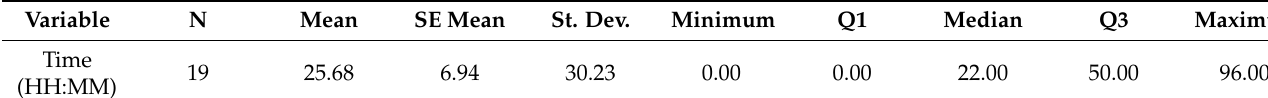
Table 2. Time taken to complete an online booking. Virtual Gemba descriptive statistics ( n = 19).